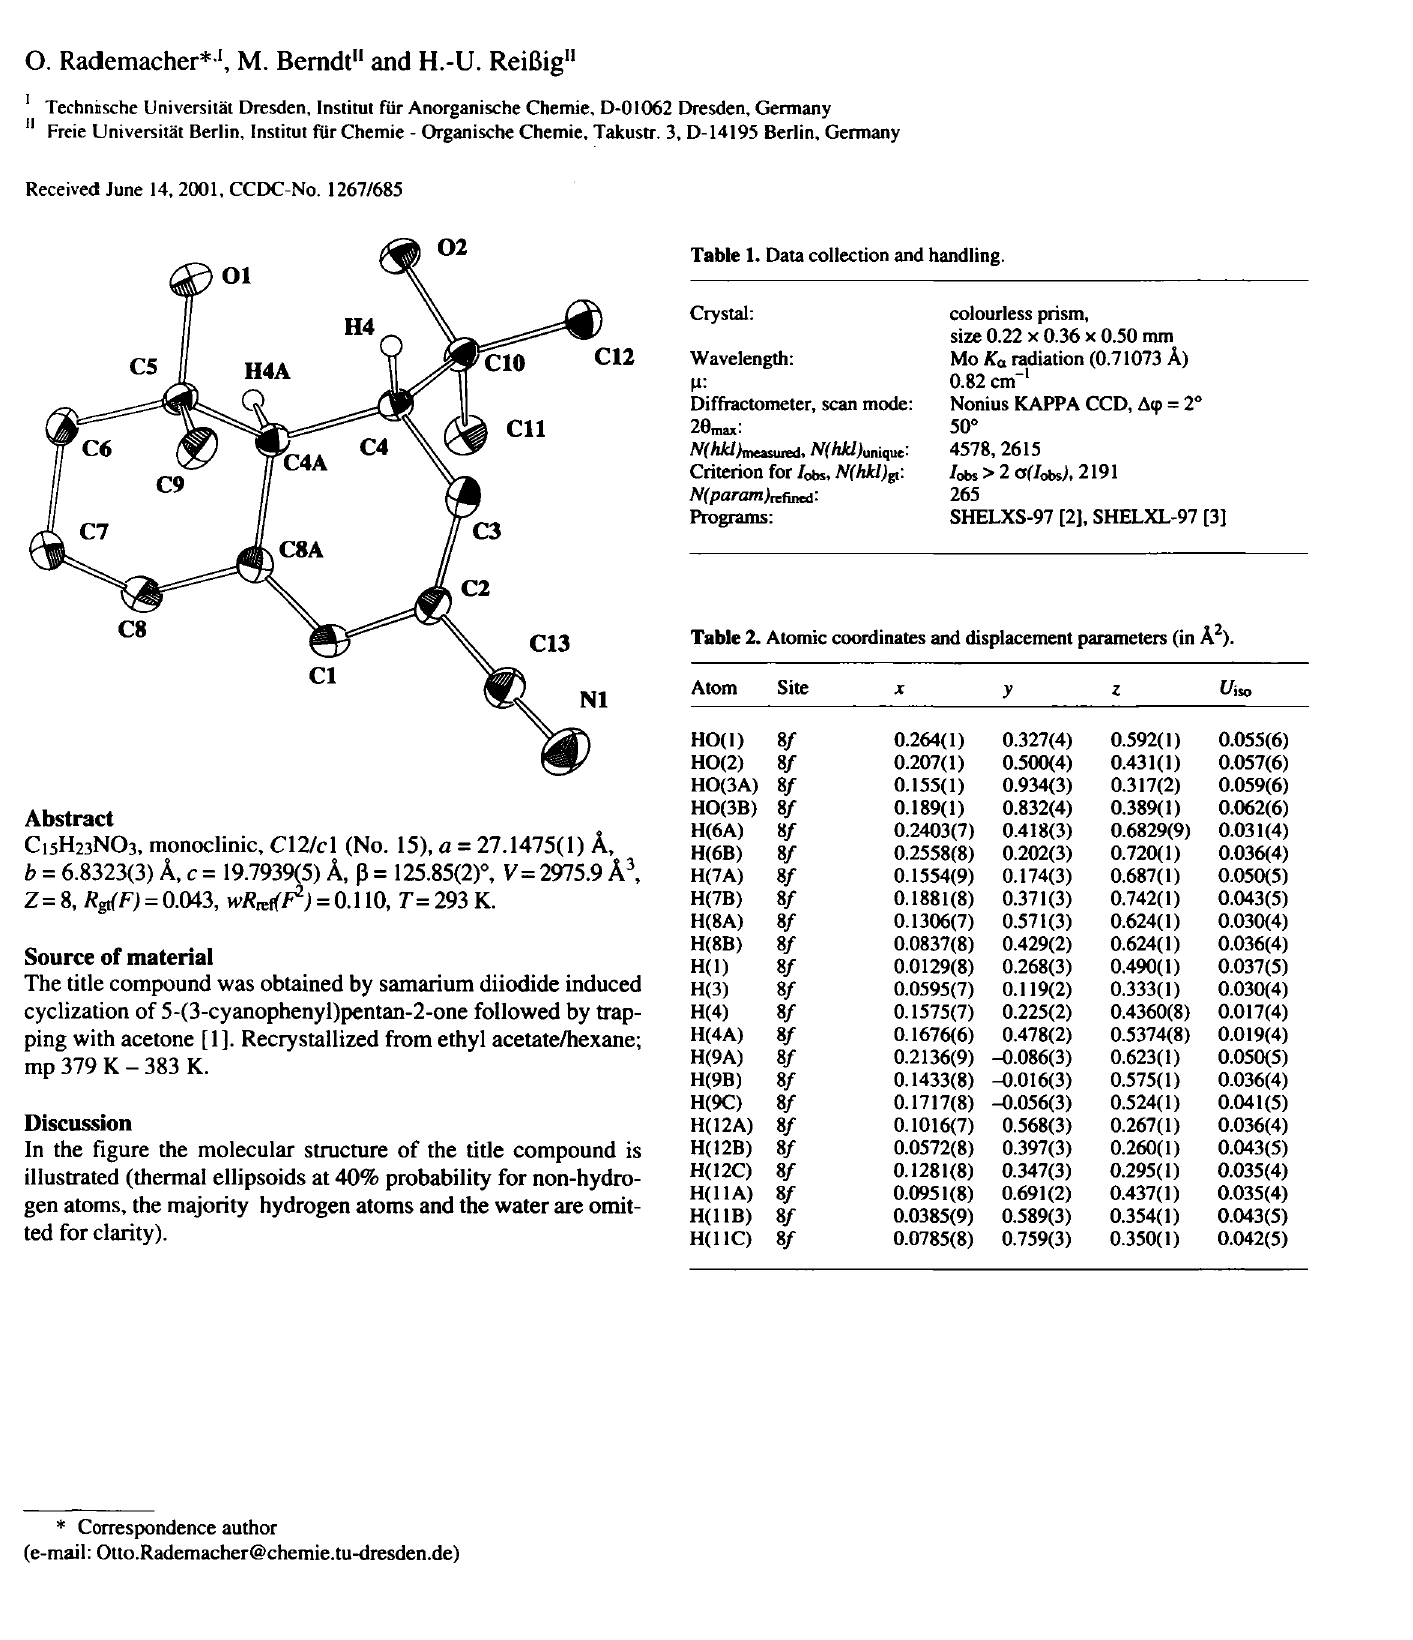
Table 2. Atomic coordinates and displacement parameters (in Ä 2